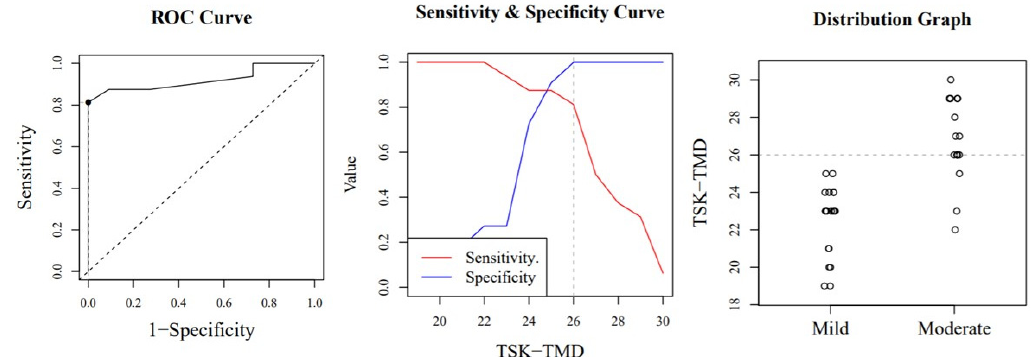
Figure A2. Optimal cut-off point between levels of jaw kinesiophobia. The image shows a ROC (Receiver Operating Characteristic) curve that represents the sensitivity of a diagnostic test that produces continuous results, depending on false positives (complementary to specificity), for different cut-off points (image on the left ), the image where the cut-off point at which the highest sensitivity and specificity is achieved (image in the middle ) and finally, a mild and moderate sample distribution graph (image on the right ).